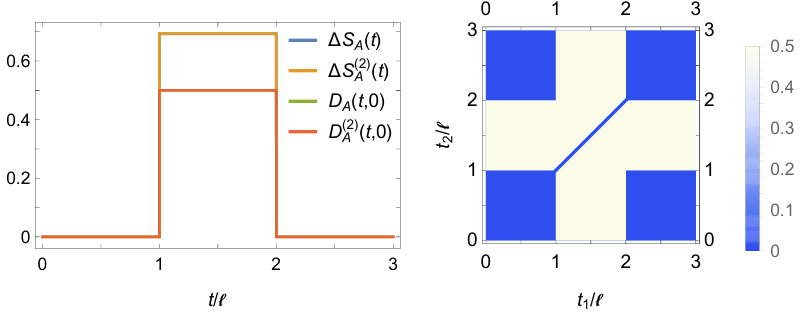
). Left: the 2 ( t ) (2.36), the trace distance A ( t; 0) (2.38). Note that the entanglement A